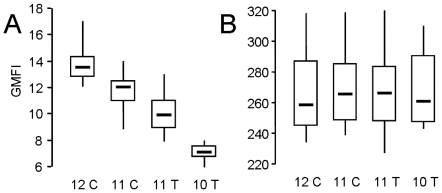
Platelet α2β1 surface expression measured by flow cytometry in whole blood.The geometric mean fluorescence intensity (GMFI) is plotted on the ordinate. A. Surface content of integrin α2β1 was measured by the binding of murine monoclonal antibody 12F1. B. Expression of integrin αIIbβ3 was measured by the binding of murine monoclonal antibody AP2. Blood was analyzed from donors who are homozygous for the following ITGA2 haplotypes: (CA)12/-52C (12 C) (n = 21); (CA)11/-52C (11 C) (n = 14); (CA)11/-52T (11 T) (n = 27); and (CA)10/-52T (10 T) (n = 8). For each dataset in these box plots, the broad horizontal bar represents the median, the box represents the second and third quartiles, and the vertical line represents the range. In A, all pair wise comparisons are statistically significant (p<0.001); in B, all pair wise comparisons are not statistically significant (p>0.95). Comparable results were obtained with murine monoclonal antibodies 6F1 and 8C12, specific for integrin α2β1 (not shown).